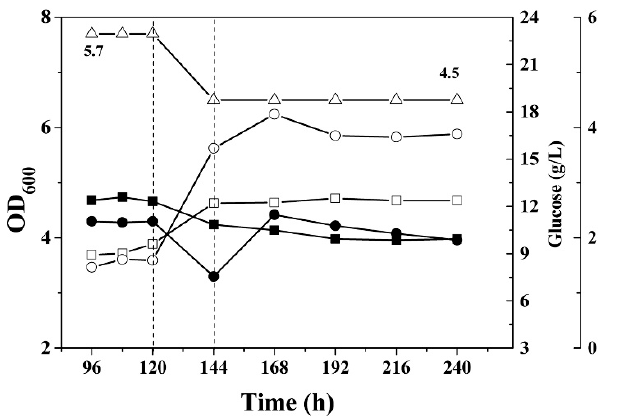
Figure 2. Growth curves and residual glucose concentration in phosphate ‐ limited continuous cul ‐ ture of C. acetobutylicum wild type and the mutant glcG ::int(1224). ( △ ), pH; ( ■ ), OD 600 of wild type; cose during cultivation of glcG ::int(1224). The dashed line indicates the initiation of dynamic pH shift from 5.7 to 4.5 in continuous fermentation.